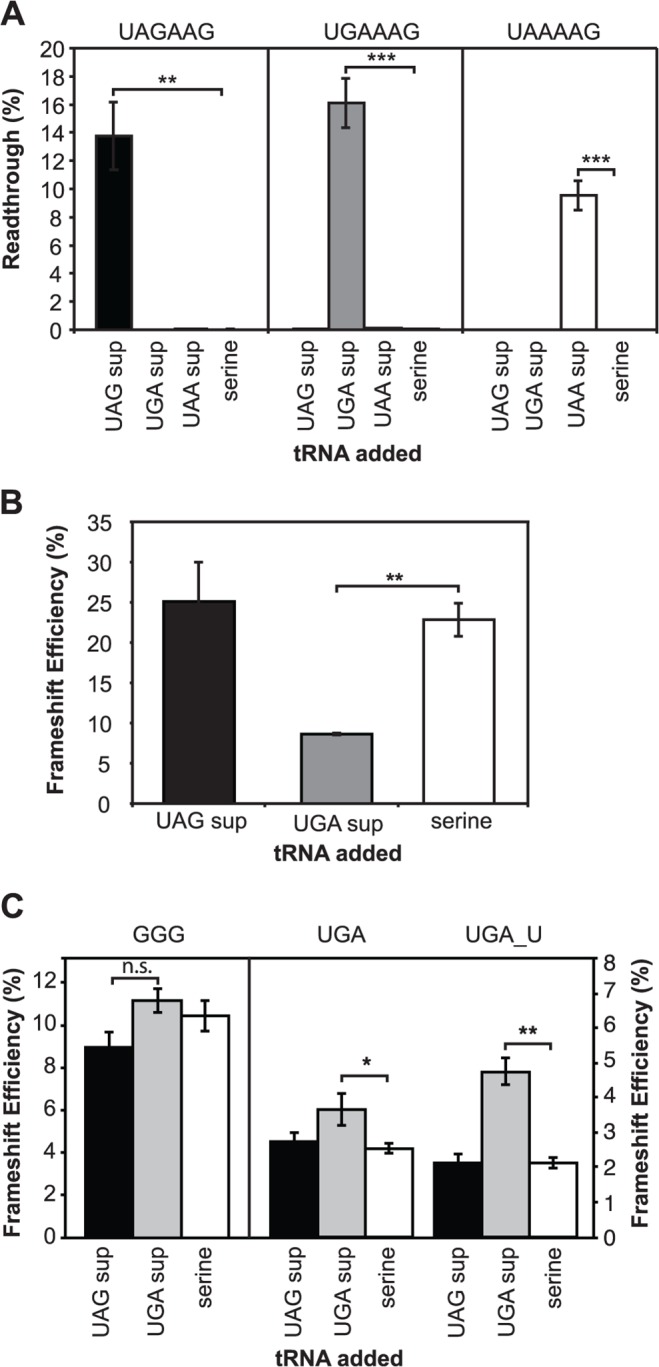
Specific intercodon suppressor tRNAs affect recoding efficiency.A. Readthrough at the test stop signals UAGAAG, UGAAAG and UAAAAG in HEK293T cells with cognate or non-cognate suppressor tRNAs (UAG [black], UGA [grey] or UAA [white]) and tRNASer as a control (serine). The mean ± SEM for four replicates is shown. B. Effect of over-expressing cognate suppressor tRNAUGA, non-cognate tRNAUAG or control tRNASer on human antizyme +1 frameshift efficiency. The mean ± SEM for four replicates is shown. C. Effect on −1 frameshift efficiency of the HIV-1 element when UAG (black) or UGA (grey) suppressor tRNAs or the control tRNASer (white) are expressed. Frameshift efficiency was measured for the cognate, non-cognate, and control tRNAs. Note the change in scales between when the intercodon is the native GGG (left) and UGA or UGA with a complementary mutation restoring the stem (UGA_U, right). The mean ± SEM for four replicates (GGG) or six replicates (UGA and UGA_U) is shown. *P = < 0.05, **P = < 0.01, ***P = < 0.001.